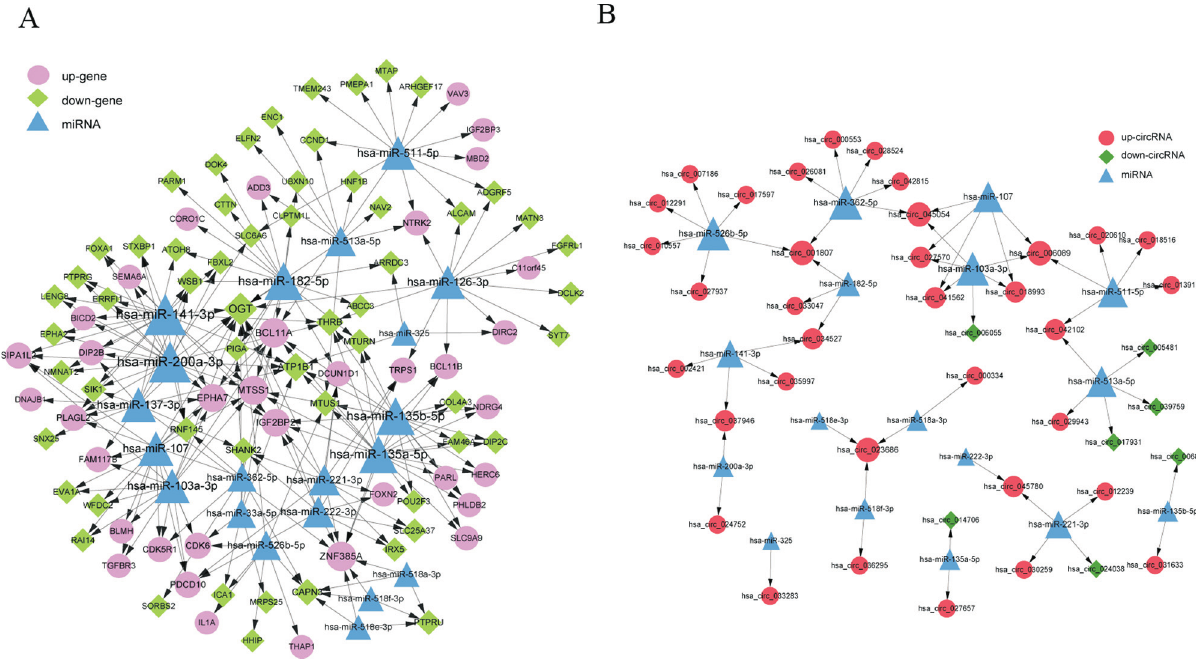
Figure2 -ThemiRNA–mRNAandmiRNA–circRNAregulatorynetworks.(A)miRNA–mRNAnetworkand(B)miRNA–circRNAregulatorynetwork. Blue triangles indicate miRNA, pink circles represent down-regulated genes, light green rhombuses indicate down-regulated genes, red circles denote up-regulated circRNA, and dark green rhombuses represent down-regulated